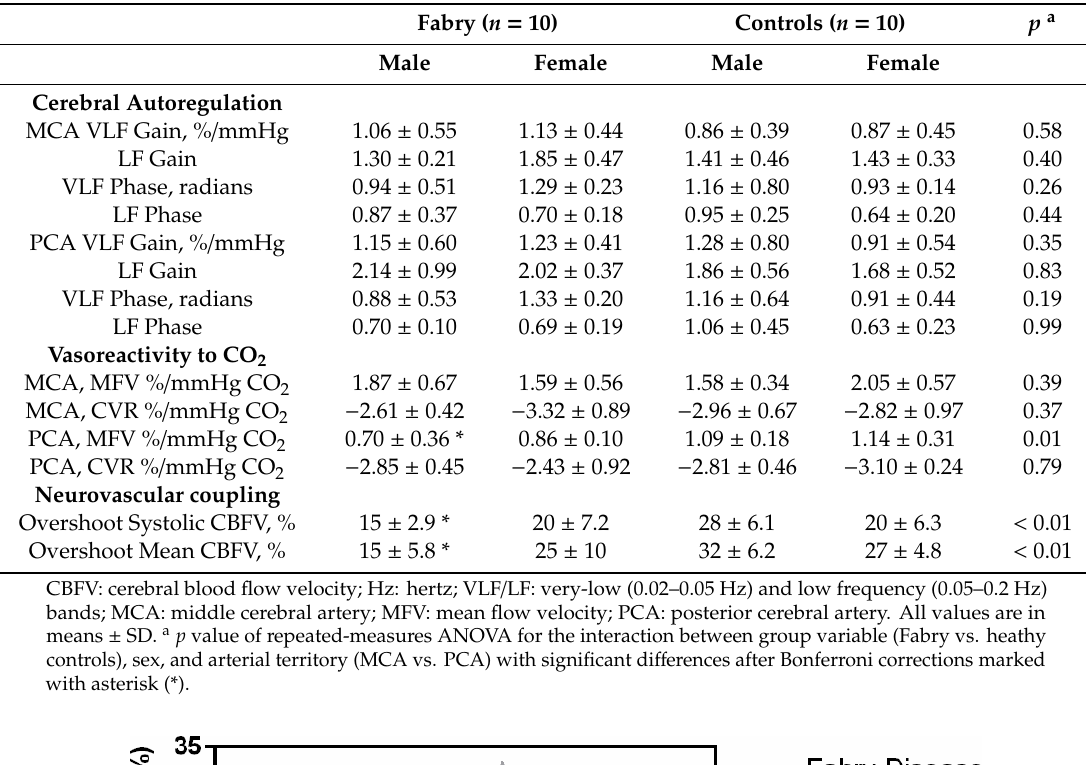
Table 2. Comparison of the cerebrovascular tests assessed by transcranial Doppler between Fabry disease and control groups, categorized by sex.